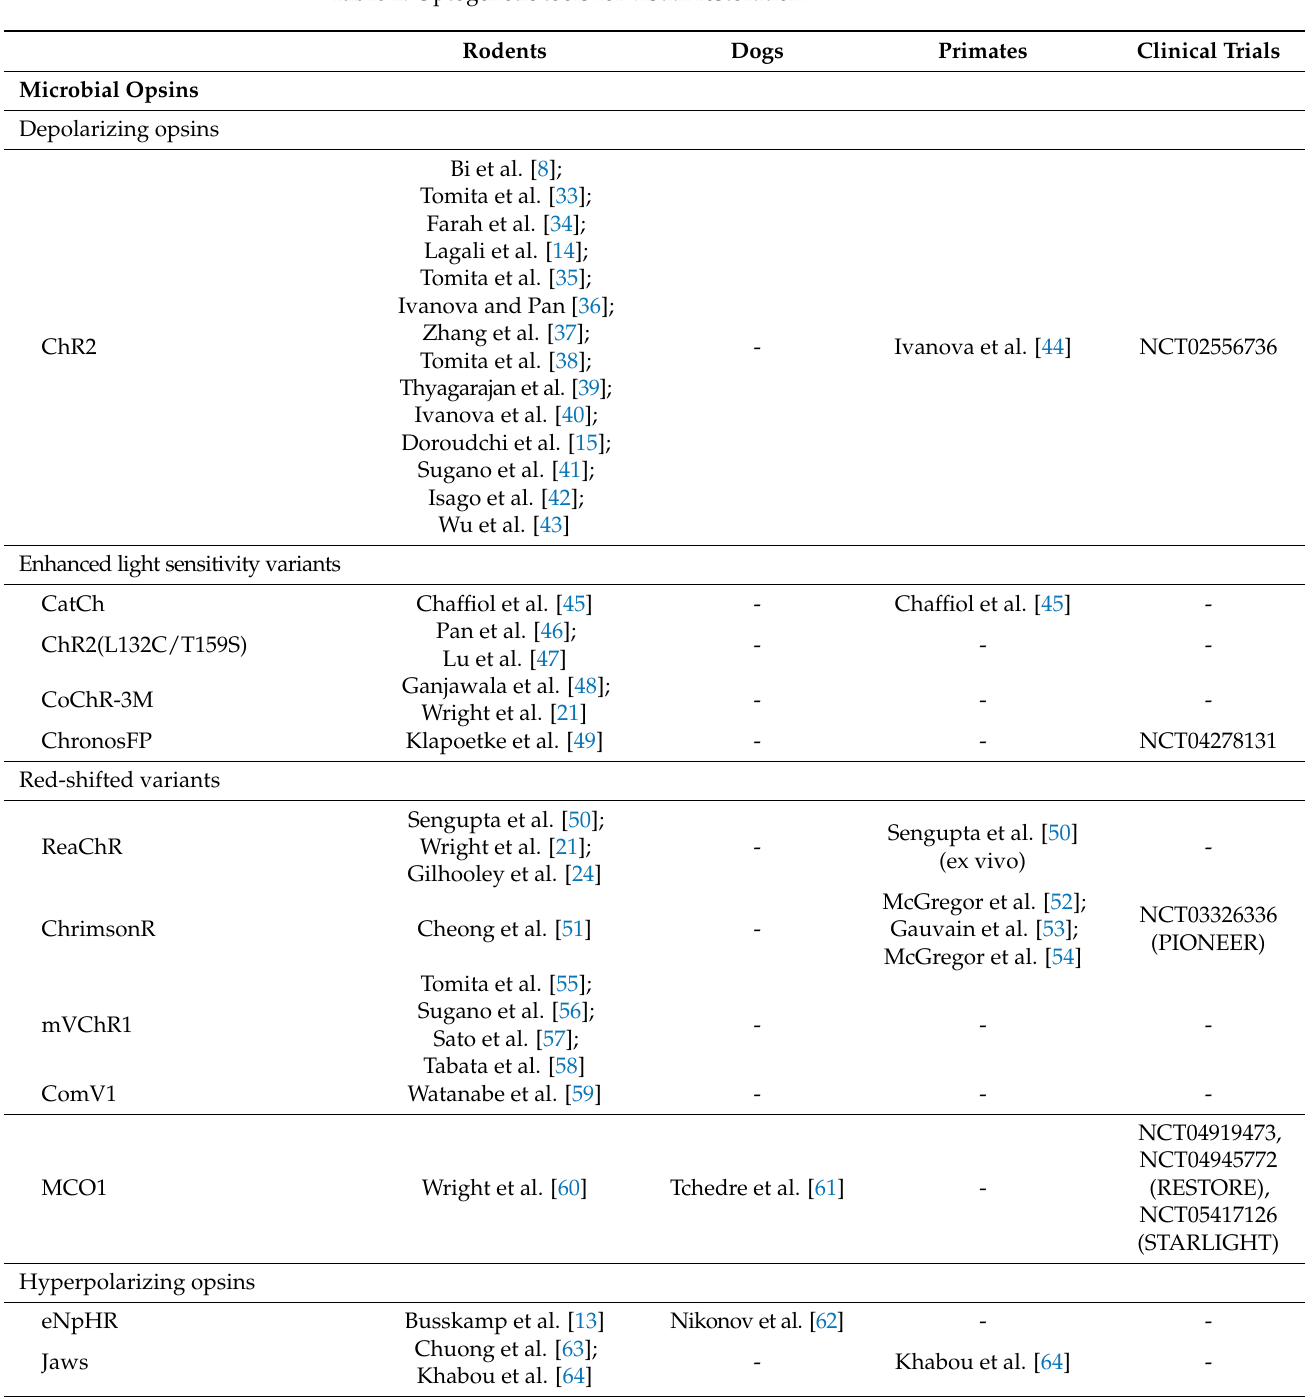
Table 1. Optogenetic tools for visual restoration. Rodents Dogs Primates Clinical